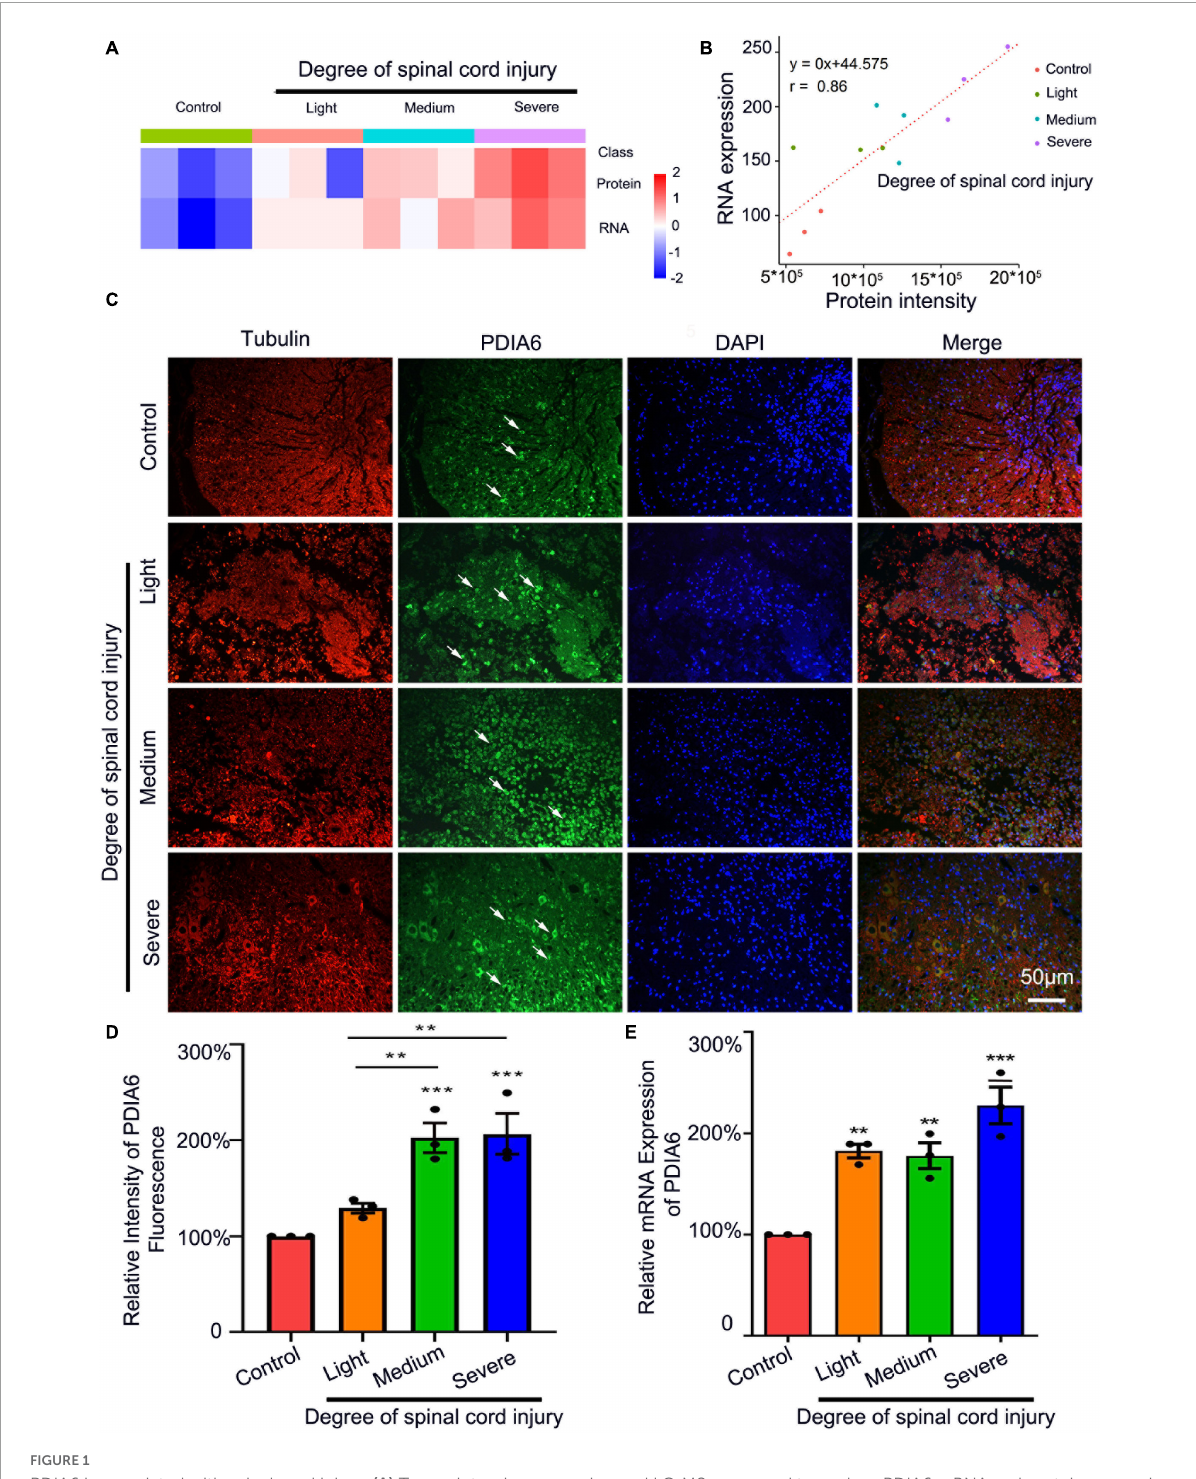
FIGURE1 PDIA6 is associated with spinal cord injury. (A) Transcriptomic sequencing and LC-MS were used to analyze PDIA6 mRNA and protein expression ( n = 3/group). (B) Correlations between changes in PDIA6 RNA and protein intensity ( n = 3/group). (C) Immunofluorescent staining was used to detect tubulin (red, Alexa Fluor 555), PDIA6 (green, Alexa Fluor 488), and DAPI (blue, Alexa Fluor 405), revealing an increase in PDIA6 expression with greater SCI severity. Scale bar: 50 µ m. (D) Immunofluorescent PDIA6 staining intensity was quantified, using β 3 Tubulin as a control ( n = 3/group). (E) Spinal cord samples from rats subjected to varying levels of SCI severity were collected to assess PDIA6 expression via qPCR ( n = 3 /group). * P < 0.05, ** P < 0.01, *** P <